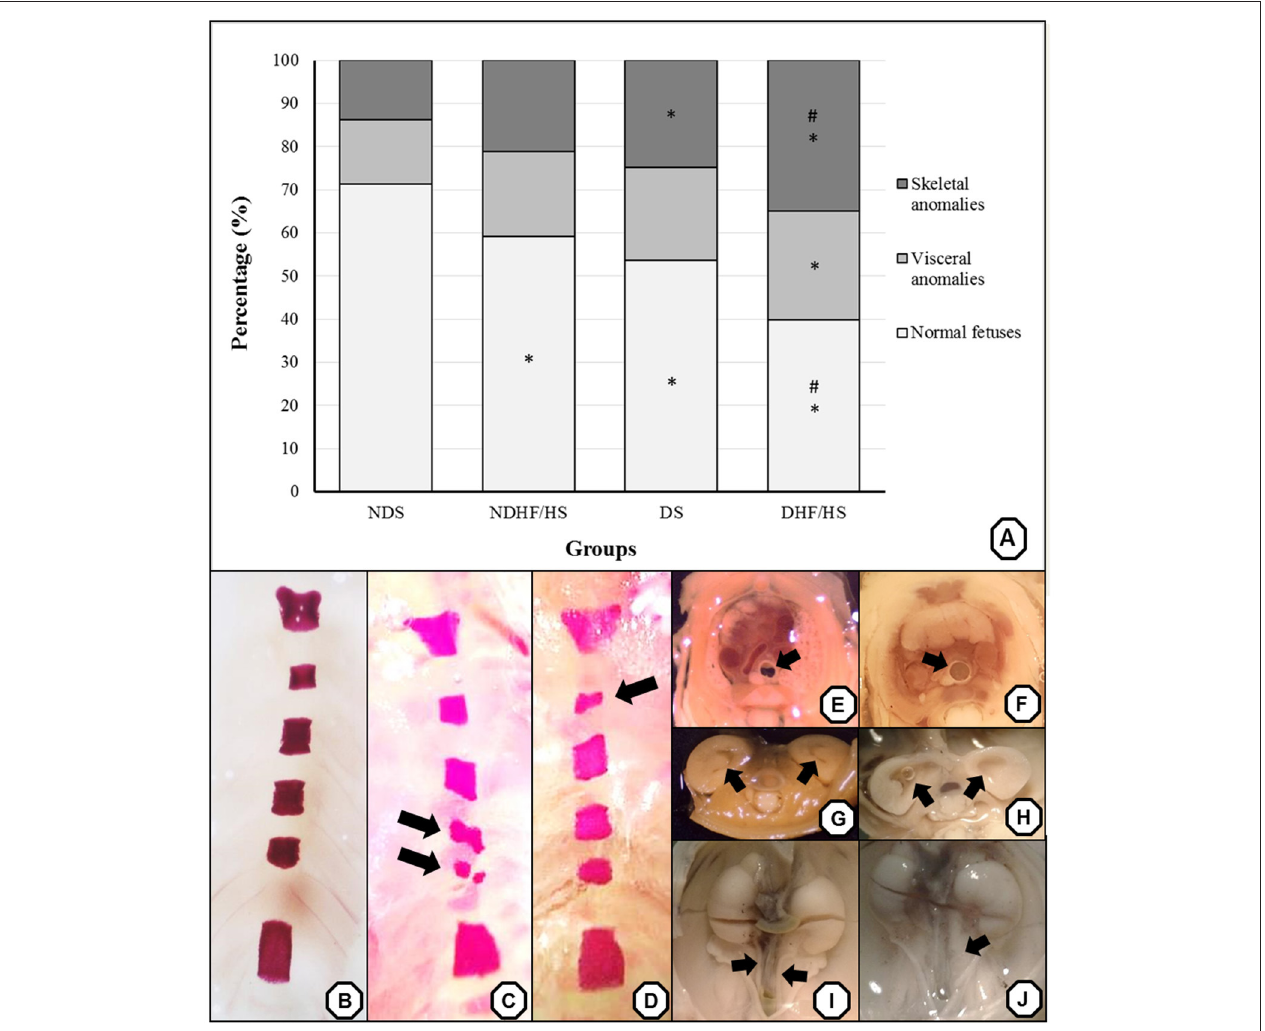
FIGURE 4 | (A) Percentage (%) of anomalies of fetuses from non-diabetic (ND) and diabetic (D) rats in treated or not (S) with high-fat/high-sugar diet (HF/HS) before and during pregnancy. Panels (B–J) —representative images of the main skeletal (B–D) and visceral (F–J) anomalies. Panel (B) —normal sternebra of rat fetuses. Panel (C) —abnormally shaped sternebra and bipartite ossification of sternebra (arrow). Panel (D) —incomplete ossification of sternebra (arrow). Panels (E,F) —a thoracic section from rat fetuses, with (E) normal trachea (arrow) and (F) dilated trachea (arrow). Panels (G,H) —a kidney transversal section from rat fetuses, with (G) normal renal calices (arrow) and (H) dilated renal calices (arrow). Panels (I,J) —the pelvis section from rat fetuses, with (I) normal ureter (arrow) and (J) enlarged ureter—hydroureter (arrow). * p < 0.05—compared with the NDS group; # p < 0.05, compared with the NDHF/HS group (Fisher’s exact